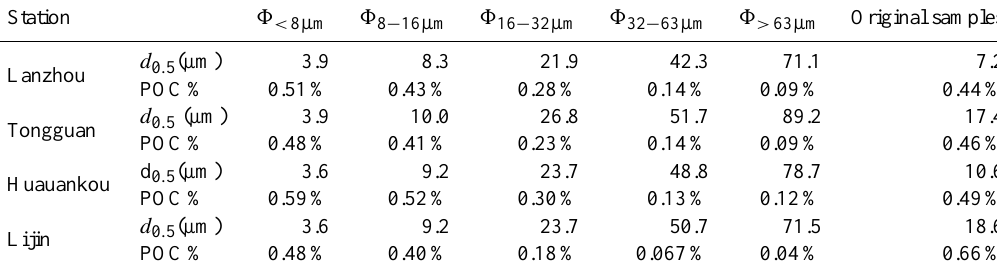
Table 1. The median size ( d 0 . 5 ) and POC% for each grain size and the original samples (2006 investigation). Station 8 < 8 µ